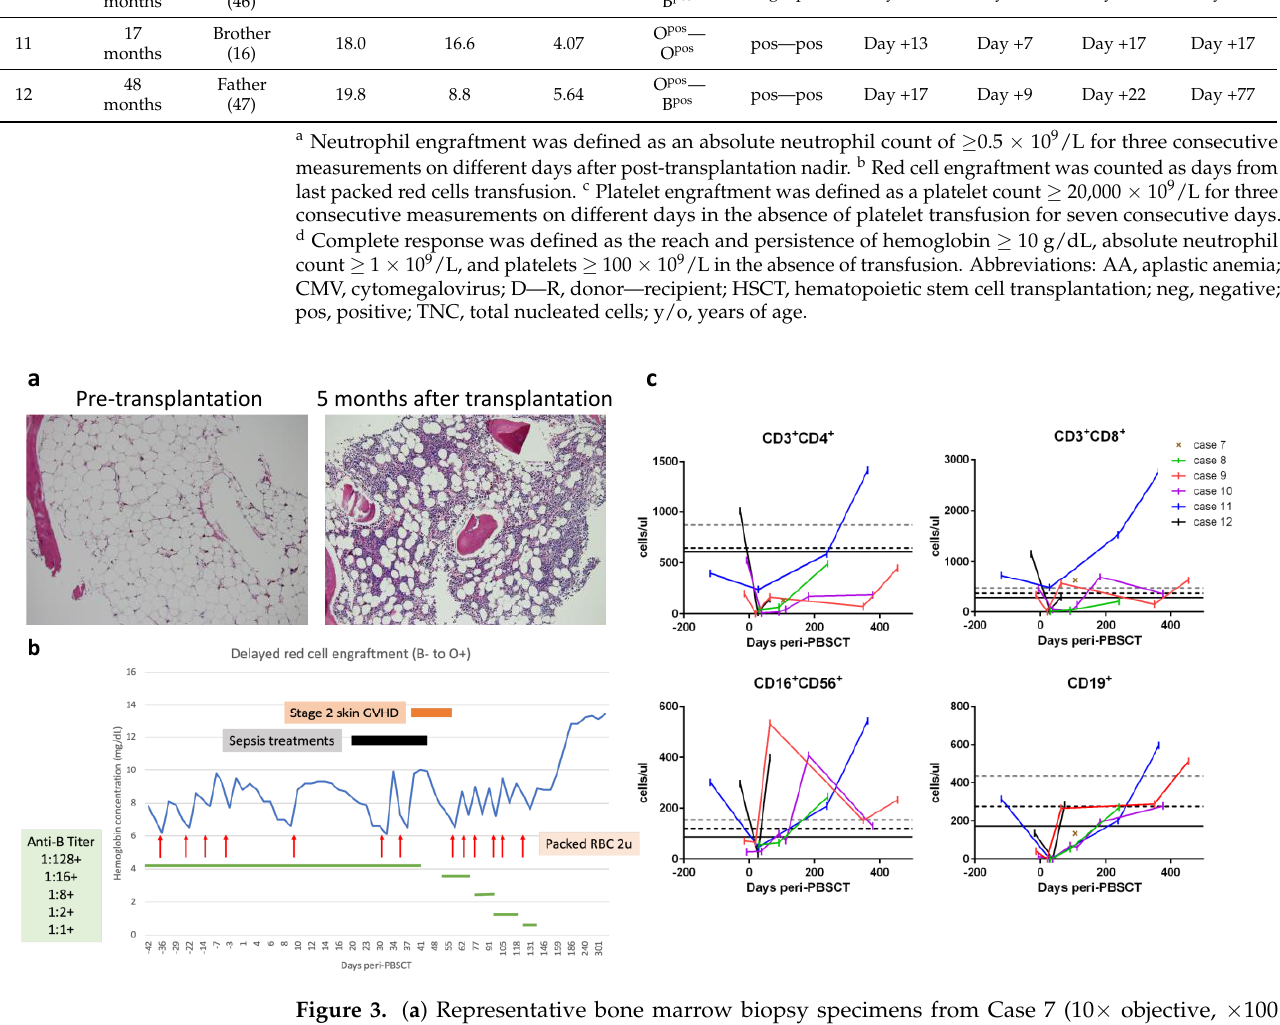
Figure 3. ( a ) Representative bone marrow biopsy specimens from Case 7 (10 × objective, × 100 magnification; hematoxylin and eosin stain) illustrating pre-transplantation hypocellularity (left image) compared to recovered cellularity five months after transplantation (right image). ( b ) The time-course of delayed red cell engraftment of Case 8. ( c ) Reconstitution of lymphocyte subsets. Grid lines at Y-axis represent the 10th percentiles of lymphocyte subsets in healthy 2 – 6-year-old (grey dashed line), 6 – 12-year-old (black dashed line), and 12 – 18-year-old (black solid line) controls.